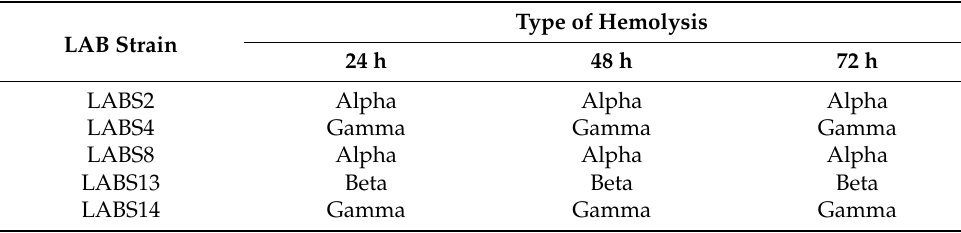
Table 6. Type of hemolytic activity on MRS agar plus 5% human blood after 24 h, 48 h and 72 h incubation at 37 ◦ C of the selected LAB strains obtained from the intestinal content of rainbow trout.